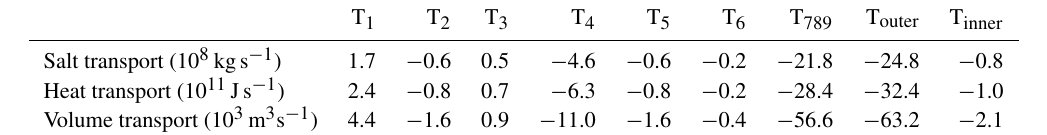
Table 1. Average heat, salt and volume transports at transects T1 to T789, as well as sum of transports at the outer